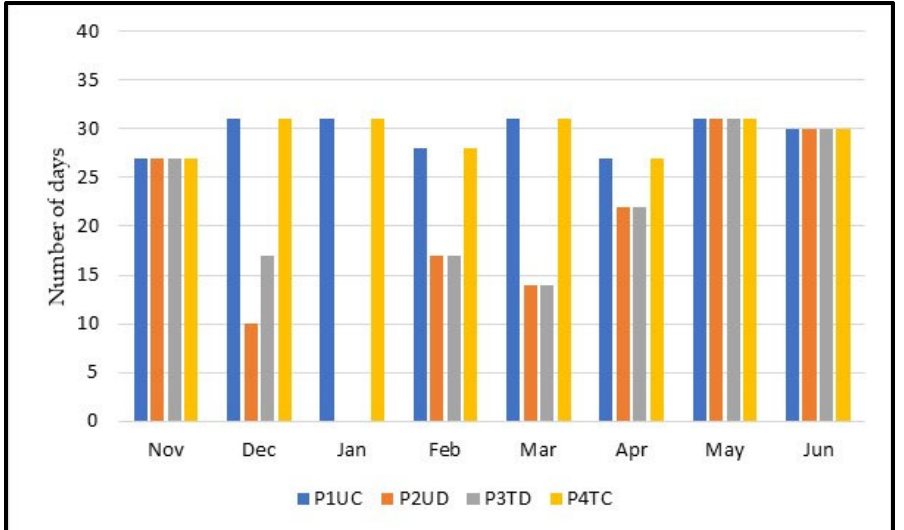
Animals 2022 , 12 , 2506 Figure 6. Number of grazing days in each treatment, per month. Figure 6. Number of grazing days in each treatment, per month.